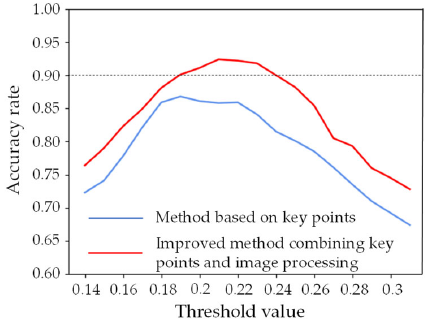
Figure 2. Detection results of open and closed eyes using two different methods.